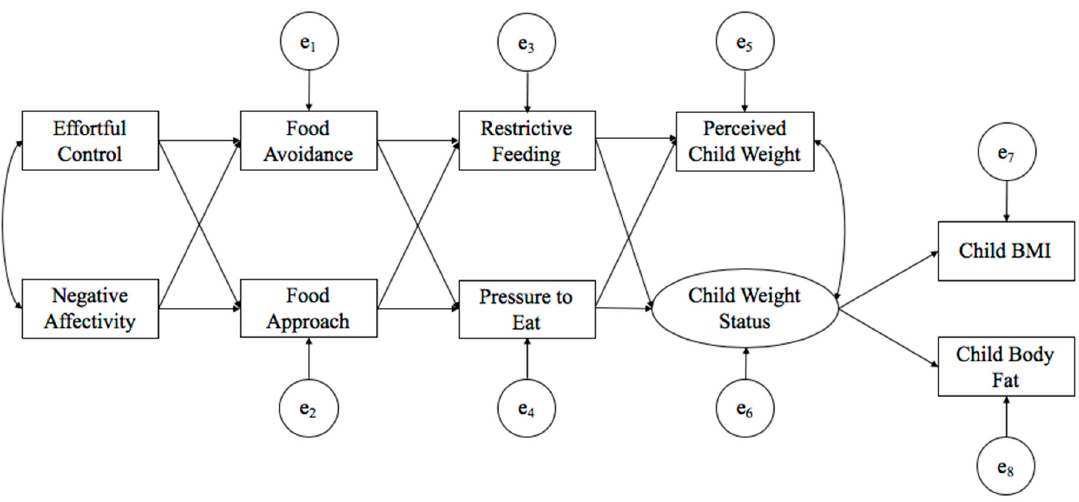
Figure 1. Hypothesized psychosocial process model of appetite self-regulation and weight status. Note. BMI = body mass index; e 1 = error term for food avoidance; e 2 = error term for food approach; e 3 = error term for restrictive feeding; e 4 = error term for pressure to eat; e 5 = error term for perceived child weight; e 6 = error term for child weight status; e 7 = error term for child BMI; e 8 = error term for child body